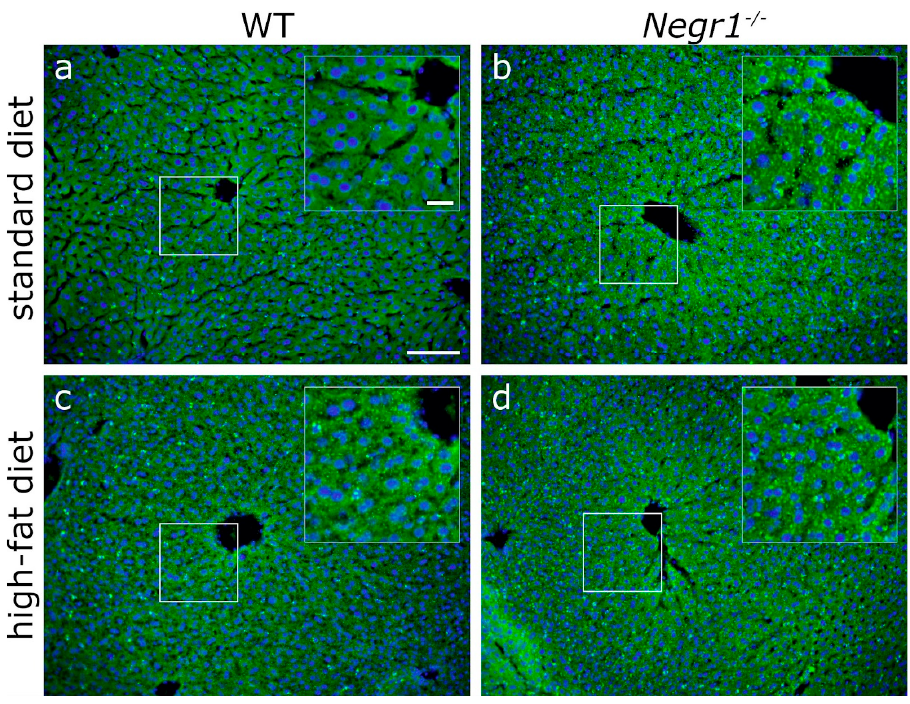
Figure 6. Hepatic lipid content. Representative images of BODIPY neutral lipid staining (green) from ( a , c ) WT and ( b , d ) Negr1 − / − mouse liver sections that underwent ( a , b ) standard and ( c , d ) high-fat diets. Compared to ( a ) WT mice, the hepatocytes from ( b ) Negr1 − / − mice in the standard diet display increased lipid droplet accumulation around the portal vein. This genotype-dependent difference is diminished with ( c , d ) high-fat diet treatment. Nuclei (blue) were stained using H33258 stain. Scale bars: 100 μ m, 25 μ m (inserts).